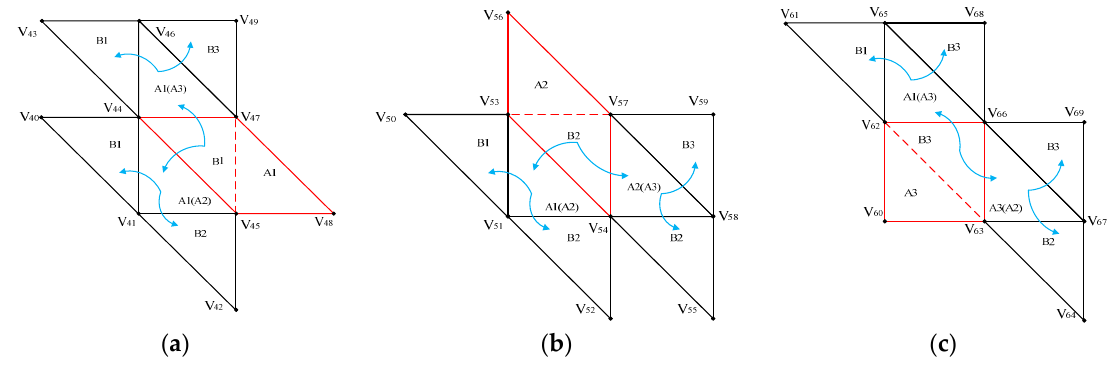
Figure 12. Transition graphs between different kinds of quadrilaterals, ( a ) the first kind of quadrilateral; ( b ) the second kind of quadrilateral; ( c ) the third kind of quadrilateral.